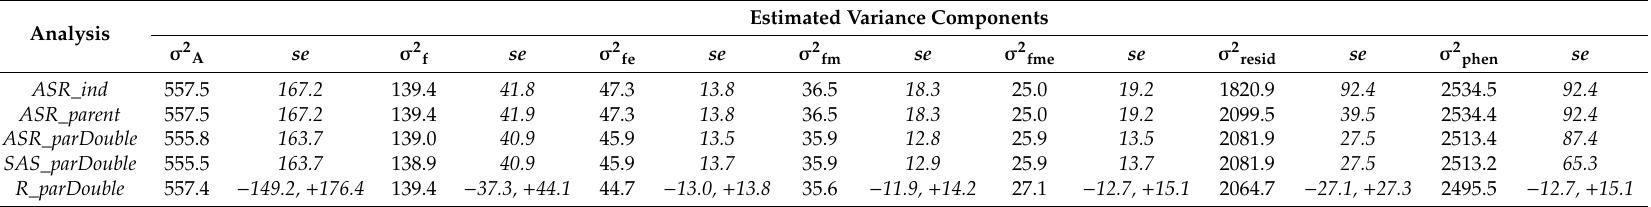
Table 2. Estimated variance components 1 and standard errors 2 from five linear mixed models 3 for a simulated full-sib progeny dataset with 40 parents, 80 families from an unbalanced mating design, 4 tests, and 25 trees / family /